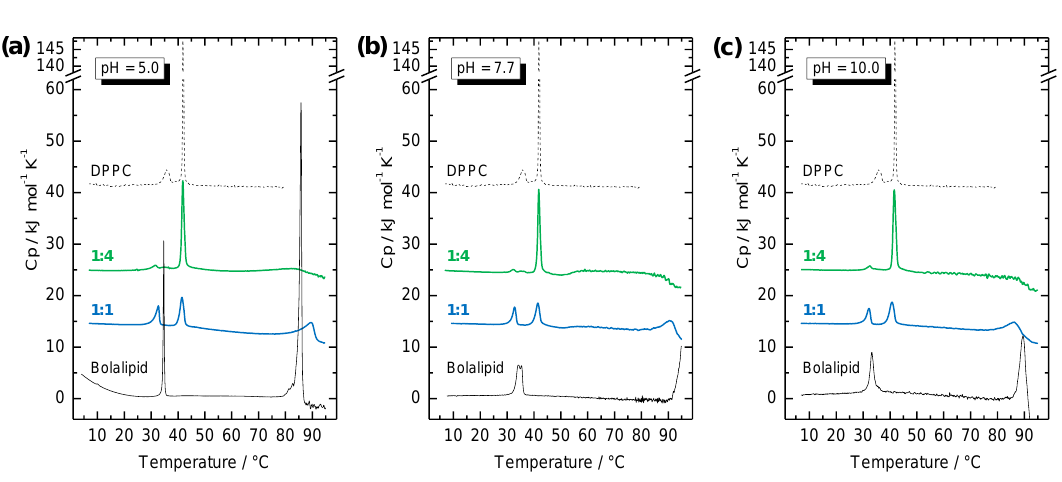
Figure 7. DSC heating curves of different Me 2 PE-Gly(2C16)C32-OH :DPPC mixtures ( c = 3 mM) in: ( a ) acetate buffer at pH = 5.0; ( b ) phosphate buffer at pH = 7.7; and ( c ) carbonate buffer at pH = 10.0. The molar ratios are 1:4 (bolalipid:DPPC, n : n ; green line) and 1:1 (blue line). DSC data of pure Me 2 PE-Gly(2C16)C32-OH ( c = 1 mg mL −1 , black solid line; in ( a ) with 25%, v / v , of ethanol) and DPPC ( c = 1 mg mL −1 , black dashed line) are shown for comparison. The heating rate was 60 K h −1 and the second heating scan is shown for all measurements. The curves are shifted vertically for clarity.